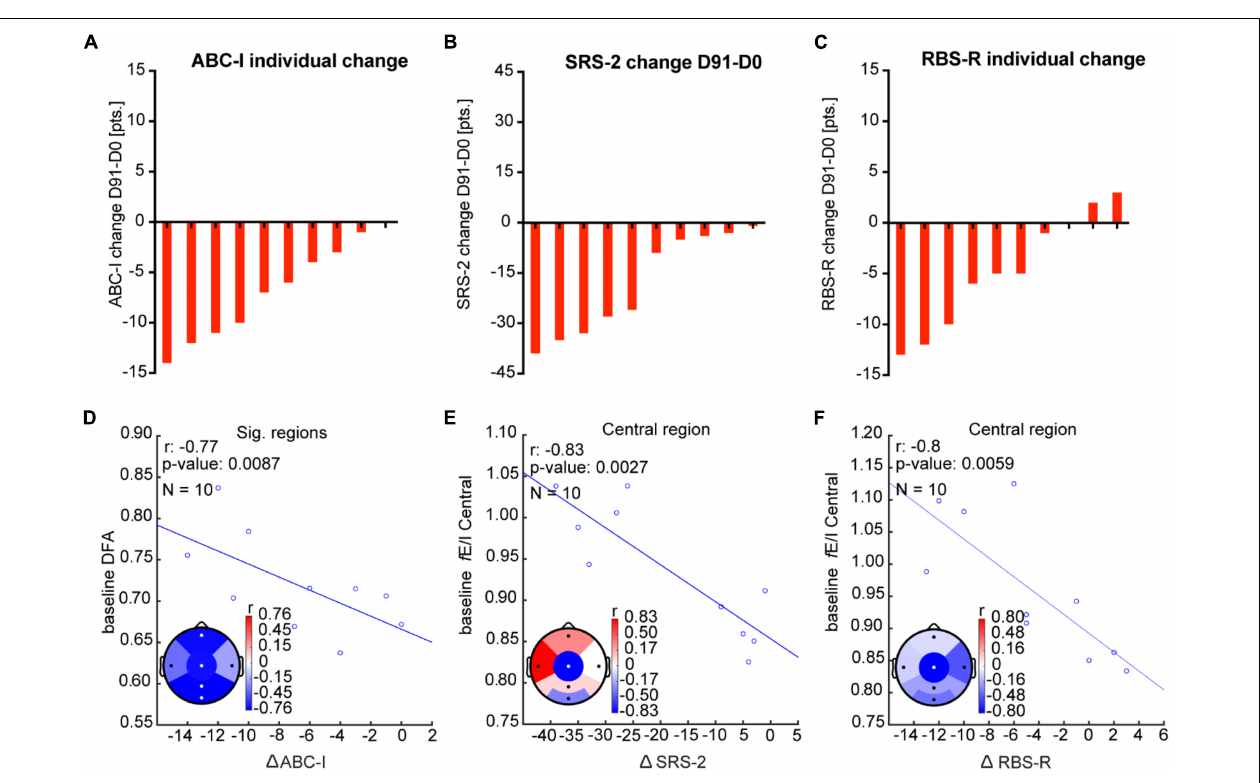
FIGURE 5 | Baseline EEG measures correlate with clinical outcomes after bumetanide. (A–C) Rank-ordered change in ABC-I, SRS-2, and RBS-R in response to bumetanide for each participant (D91-minus-D0). (D) Improvement in irritability score (ABC-I) was strongly related ( rho = 0.8) to higher DFA at baseline, particularly in frontal, central, parietal, and occipital regions. (E,F) . We found a strong correlation ( rho = 0.8) between high f E/I at baseline in the central region and improvement in SRS-2 and RBS-R. Significant regions are represented with white dots (Pearson correlation coefficient, p < 0.05, FDR corrected q =